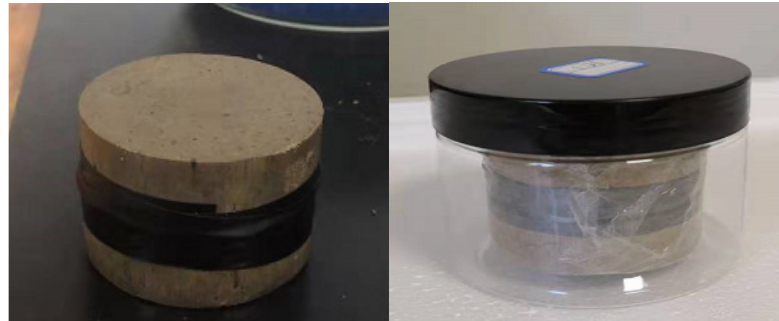
Figure 3. Specimen during matric suction test.